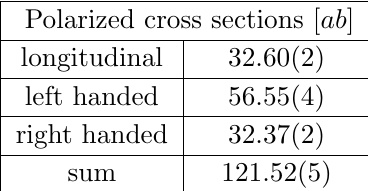
Table 11 . Polarized cross sections ( ab ) for the VBS ZZ production in the absence of lepton cuts.